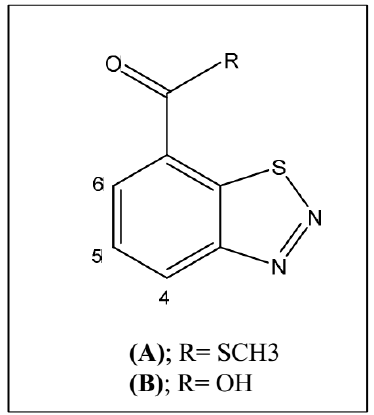
Figure 1. Chemical structures of BTH ( A ) and hydrolyzed BTH ( B ).